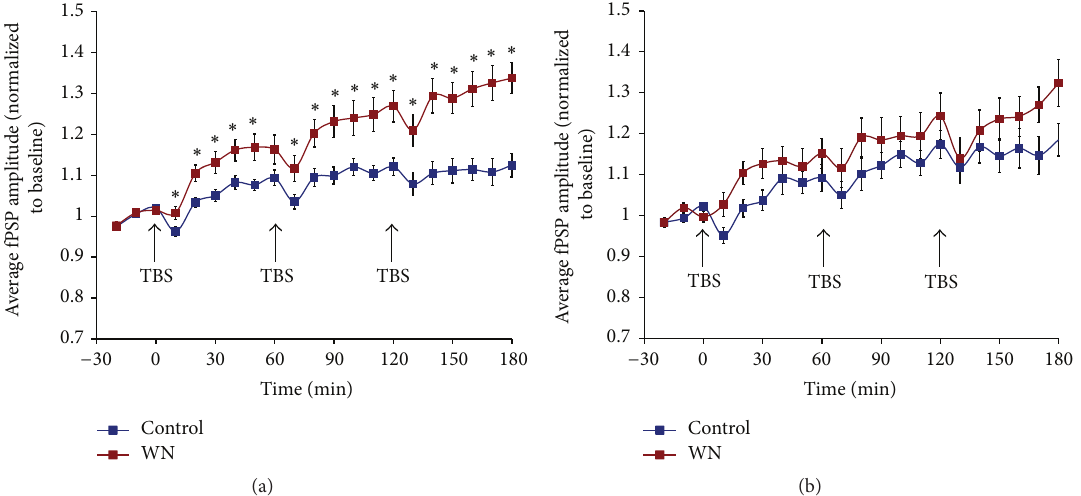
Figure 2: Amplitude of the first (a) and second (b) peak of fPSPs recorded in A1 of rats reared under WN ( 𝑛 = 18 ) and age-matched controls ( 𝑛 = 18 ) following MGN stimulation. TBS (indicated by arrows) of the MGN resulted in significant increases in the amplitude of both fPSP peaks in the two groups of animals. (a) For the first fPSP peak, rats reared in WN showed significantly more LTP than controls. ANOVA results for (a): effect of time, F (3.57, 121.25) = 43.9, 𝑃 < 0.001 ; effect of rearing condition, F (1, 34) = 12.2, 𝑃 < 0.05 ; effect of time by condition interaction, F (3.57, 121.25) = 7.9, 𝑃 < 0.001 ; ∗ indicates significant simple effects, 𝑃 < 0.05 . (b) Rearing under WN did not significantly enhance LTP of the second fPSP peak. ANOVA results for (b): effect of time, F (4.88, 165.88) = 21.4, 𝑃 < 0.001 ; no effect of condition, F (1, 34) = 2.0, 𝑃 > 0.05 ; no effect of time by condition interaction, F (4.88, 165.88) = 1.3, 𝑃 > 0.05 .